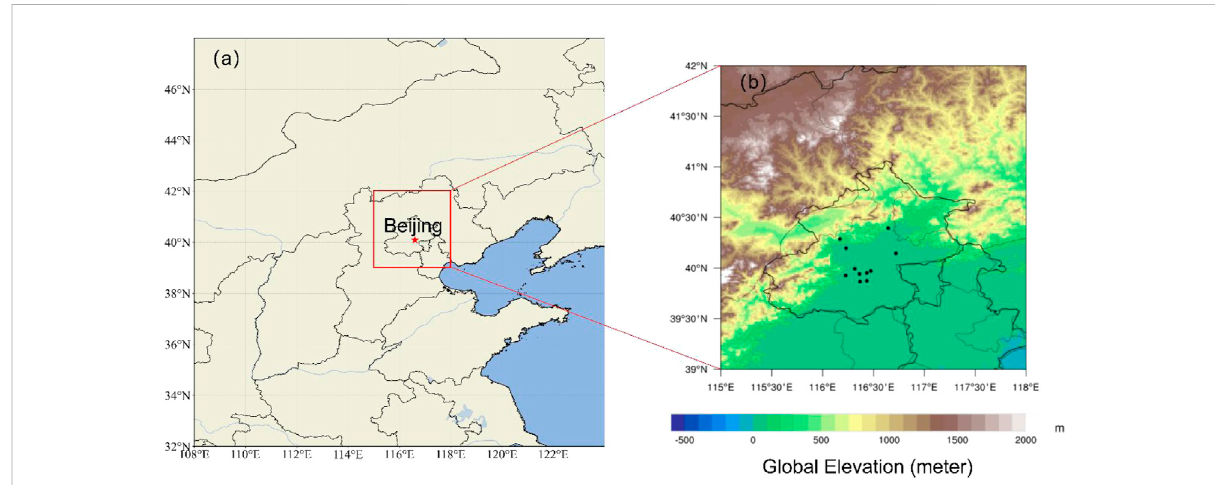
FIGURE 1 The location of Beijing (A) and the surrounding terrain of Beijing (B) . The black dots represent the locations of the environmental monitoring stations, and the red star represents the location of the meteorological observation